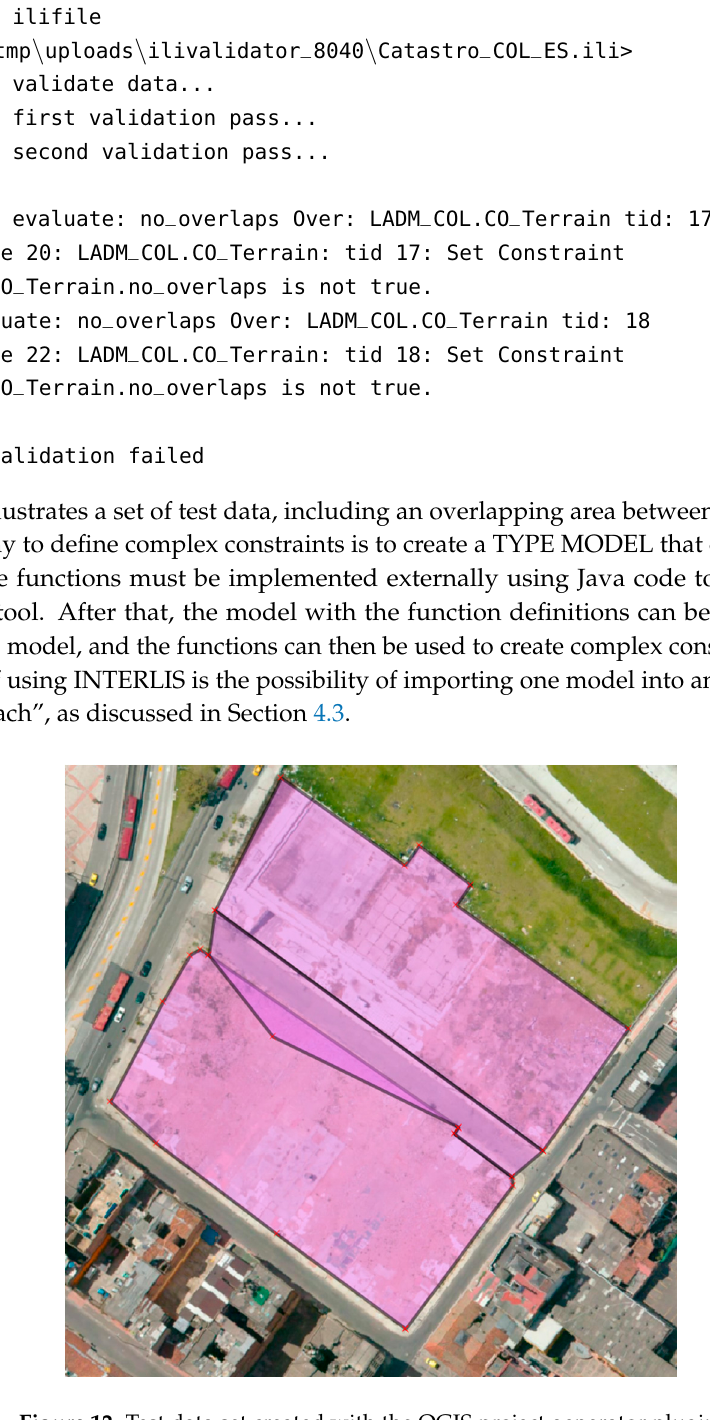
Figure 12. Test data set created with the QGIS project generator plugin.